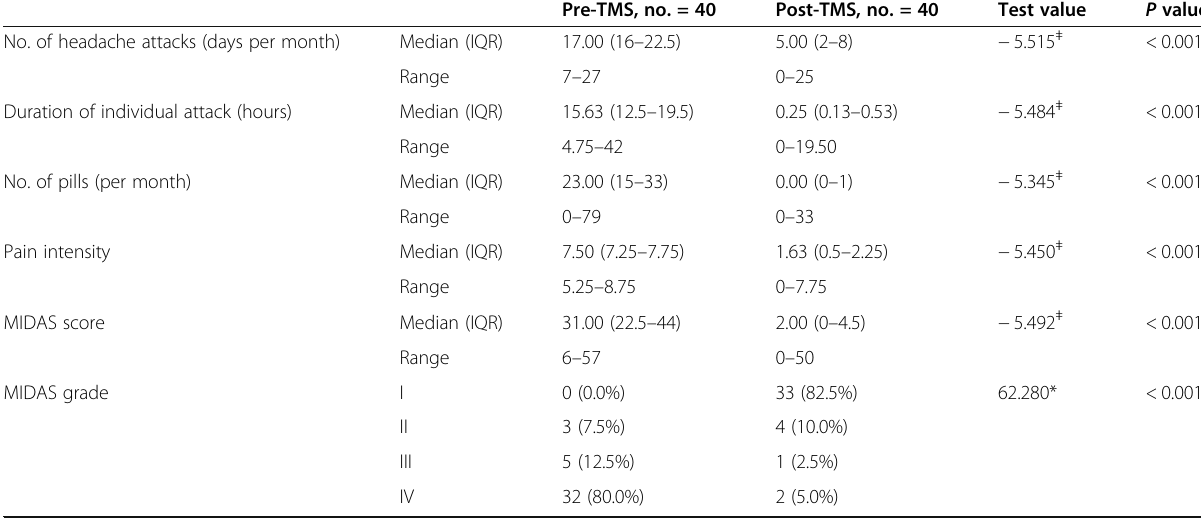
Table 1 Comparison between 4 weeks pre- and 4 weeks post-TMS treatment as regards clinical data of migraine and MIDAS in the patient group